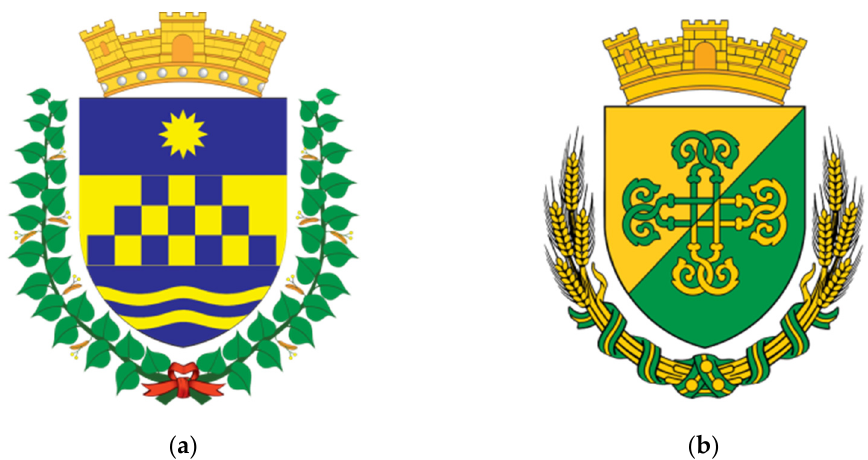
Figure 21. ( a ) Coat of arms of Karposh, unofficial; ( b ) Coat of arms of Sveti Nikole (2014–2018). The purpose and use of each of the achievements of the Arms are prescribed by the Rulebook for the Use of Arms and the Flag ( Правилник 2013). Heraldic badges can be based on the Arms but may also be independent of them.